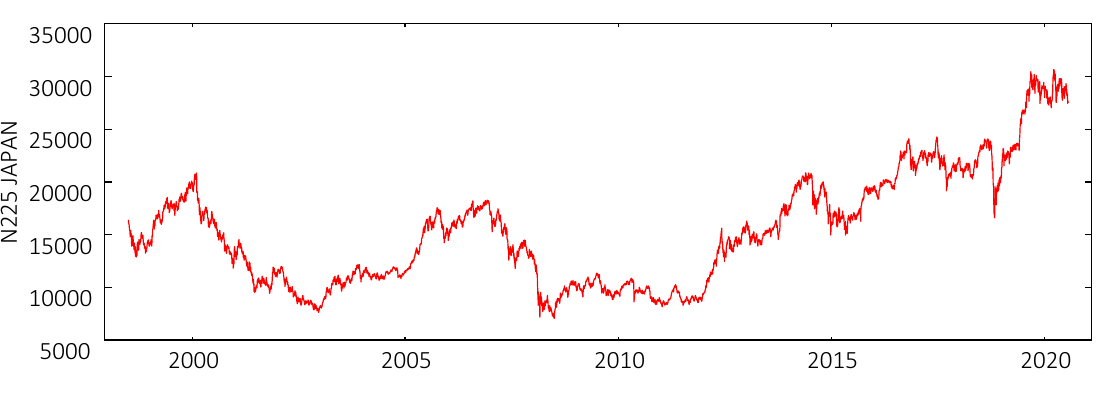
Figure 1. The trend of the NIKKEI 225 index using daily closing prices during the sample period